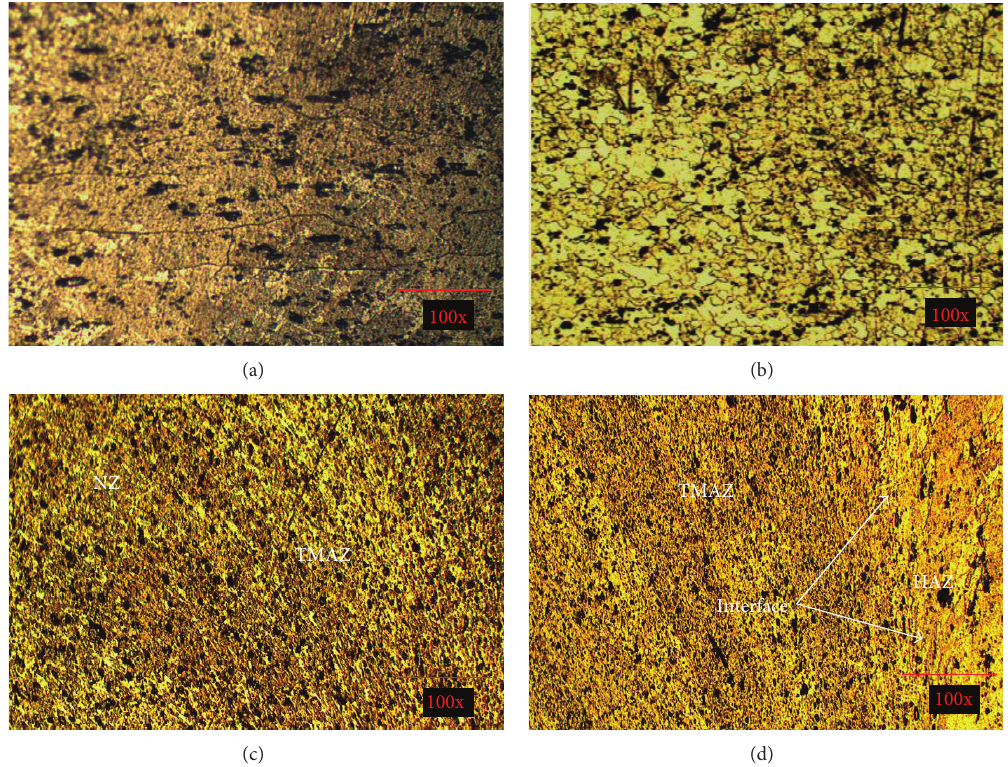
Figure 9: Optical images reveal the microstructures of different welding zones on Al-Al butt welded joint performed by the FSW technique at a rotational speed of 1750 rpm. (a) BM, (b) NZ, (c) NZ and TMAZ, and (d) TMAZ and HAZ 100x magnification.